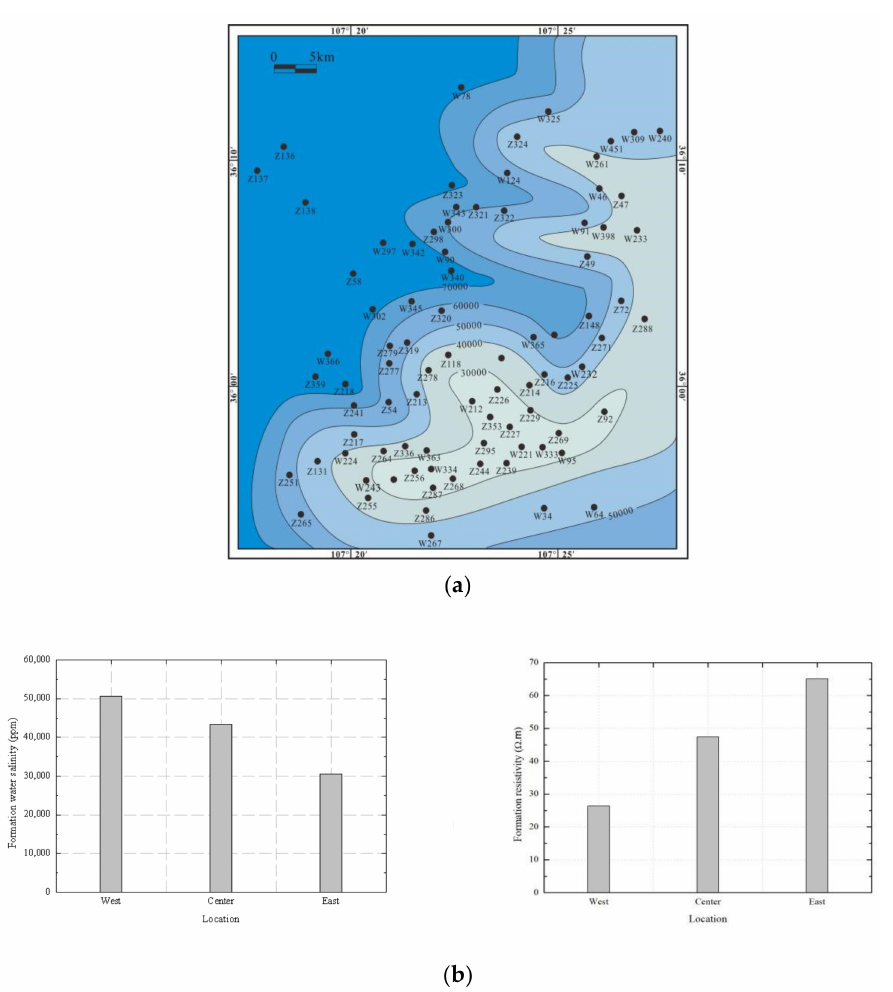
Figure 4. ( a ) Contour map of formation water salinity in the study area (ppm); ( b ) histogram of formation water salinity and formation